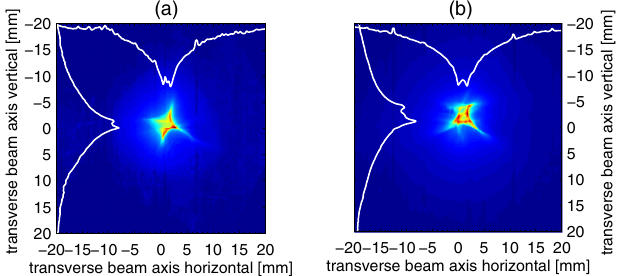
(a) focusing 9.4 MeV or (b) 5 MeV protons at 1.07 m 5.23 T, respectively. The focal spot contained (a) 4 (cid:3) 10 8 and (b) 1 : 6 (cid:3) 10 9 protons and was about 5 (cid:3) 5 mm 2 . Figure 5(a) shows the proton focus at a distance of 2.12 m to the source in the RCF layer, which corresponds